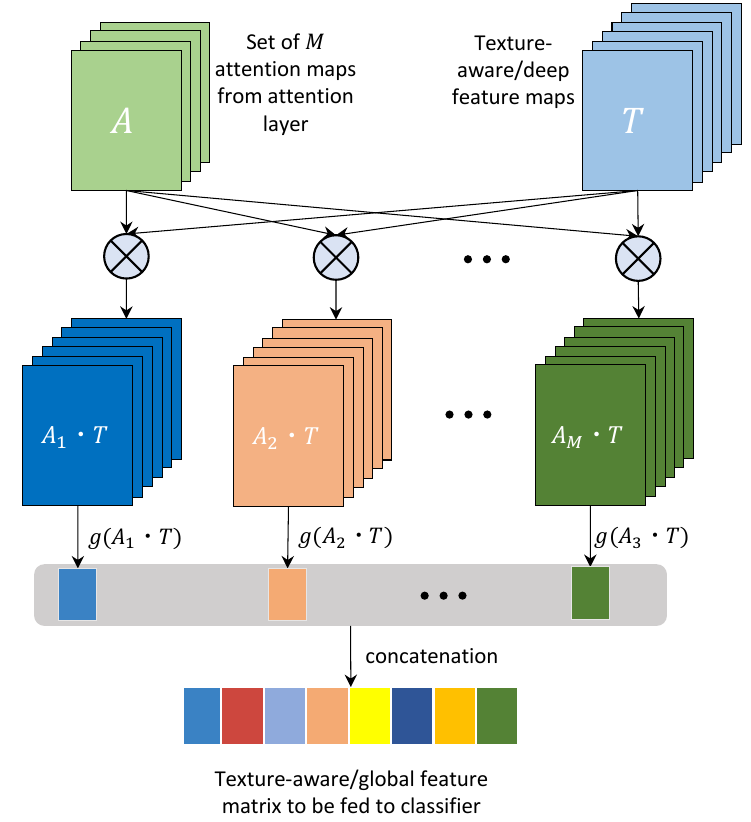
Figure 4. Texture-aware discriminative feature extraction through attention analysis and normalized average pooling. Discriminative features are pooled using localized feature maps, which are the product of element-wise multiplication of texture-aware feature maps with unique attention